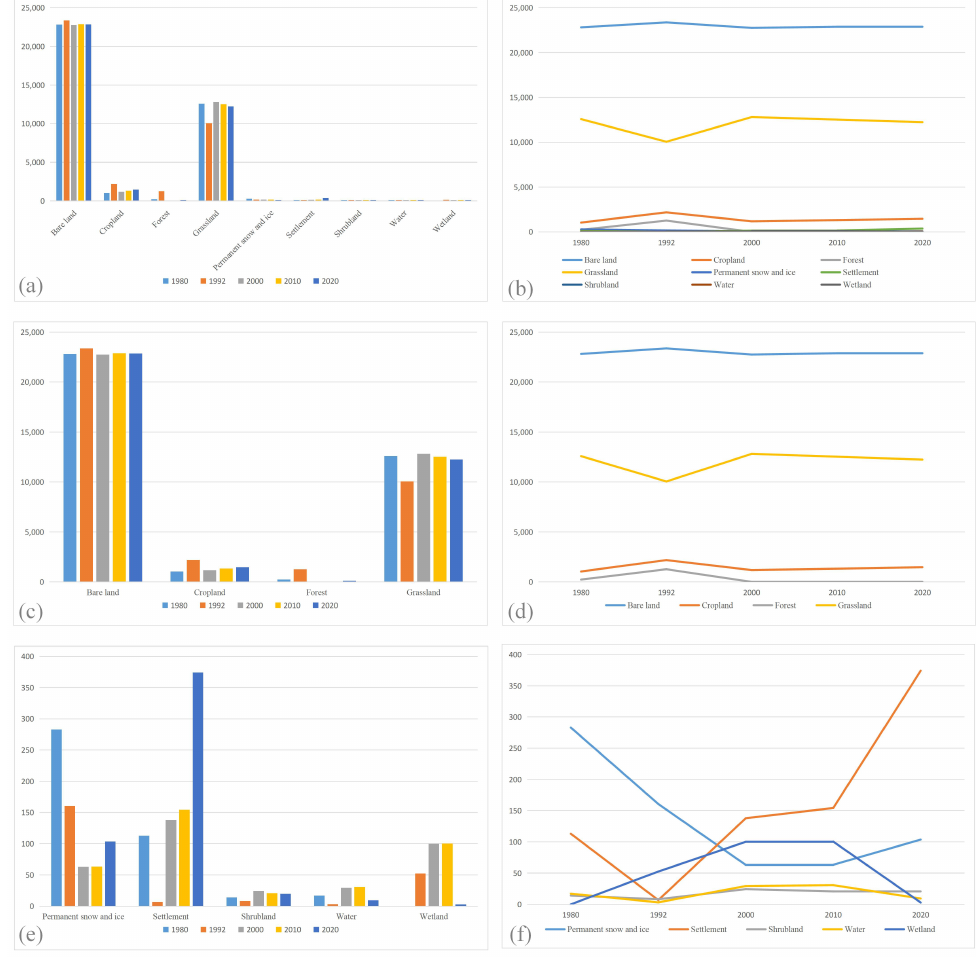
Figure 10. Three sets of graphs. The first set shows a statistical histogram ( a ) and a line chart ( b ) of the area of the nine reclassified land types in the Turpan Basin from 1980 to 2020. The second set shows a statistical histogram ( c ) and a line chart ( d ) of the area of the four reclassified land types in the Turpan Basin, including bare land, grassland, arable land, and forest land, from 1980 to 2020. The third set shows a statistical histogram ( e ) and a line chart ( f ) of the area of the five reclassified land types in the Turpan Basin, including permanent snow and glaciers, residential areas, shrubs, waters, and wetlands, from 1980 to